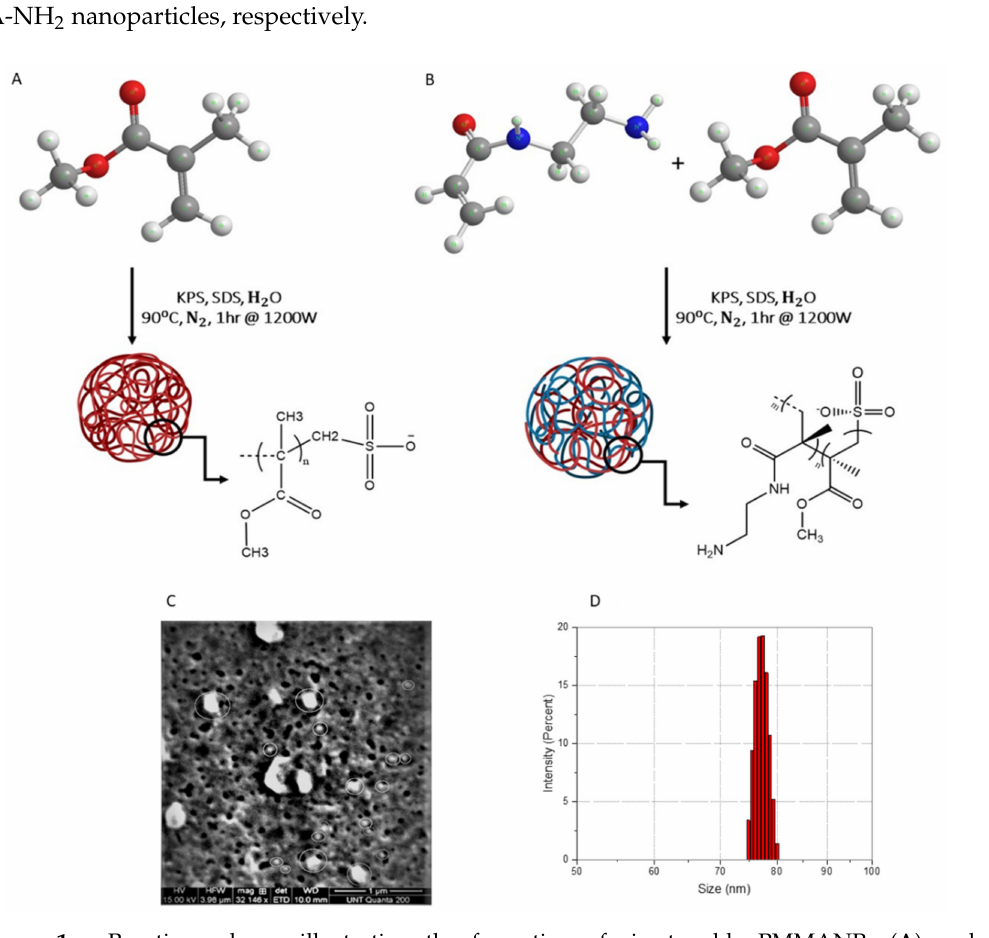
Figure 1. Reaction scheme illustrating the formation of size-tunable PMMANPs ( A ) and H 2 N-PMMANPs ( B ). SEM micrograph of PMMANPs produced with 0.013 wt. / wt.% of sodium dodecyl sulfate (SDS) ( C ) and the size distribution by intensity obtained from DLS measurements for the same sample ( D